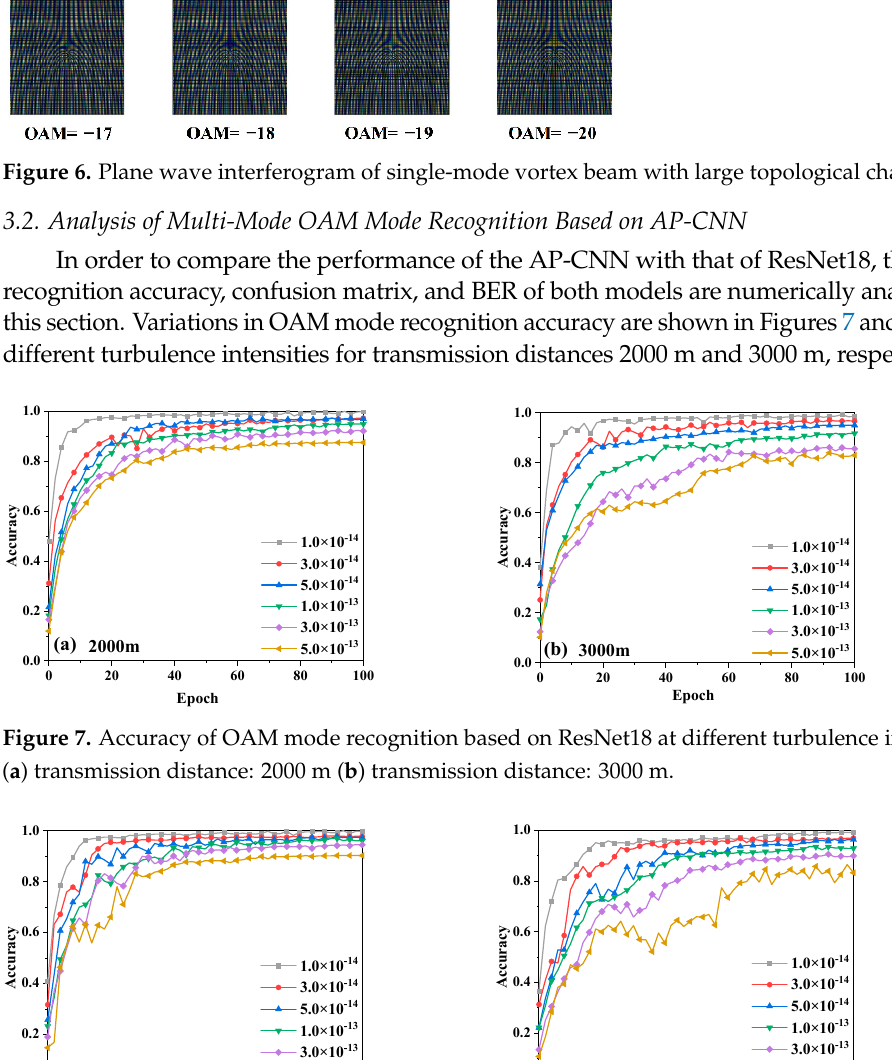
Figure 6. Plane wave interferogram of single-mode vortex beam with large topological charge.